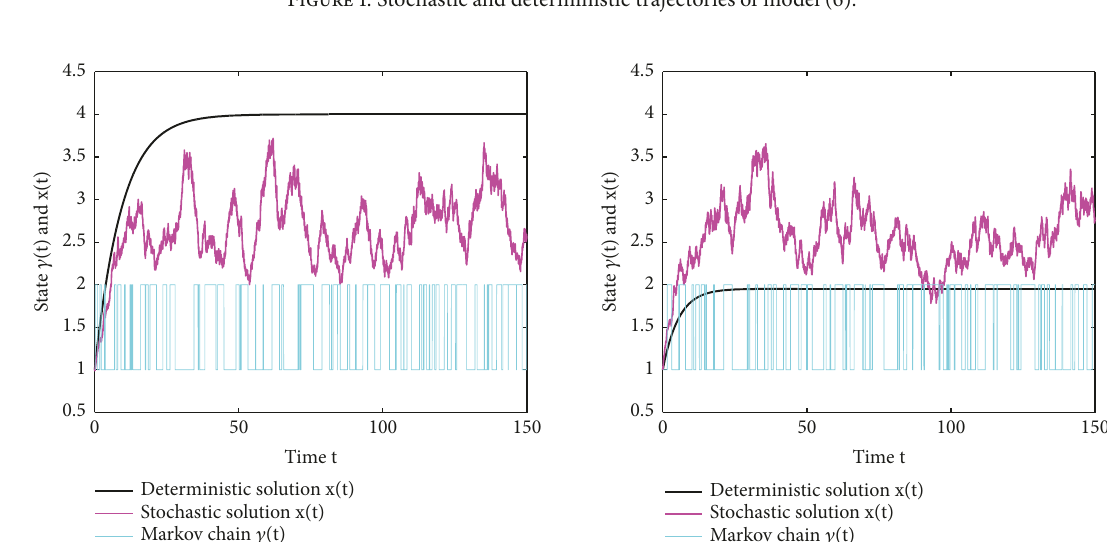
Figure 2: Stochastic and deterministic trajectories of model